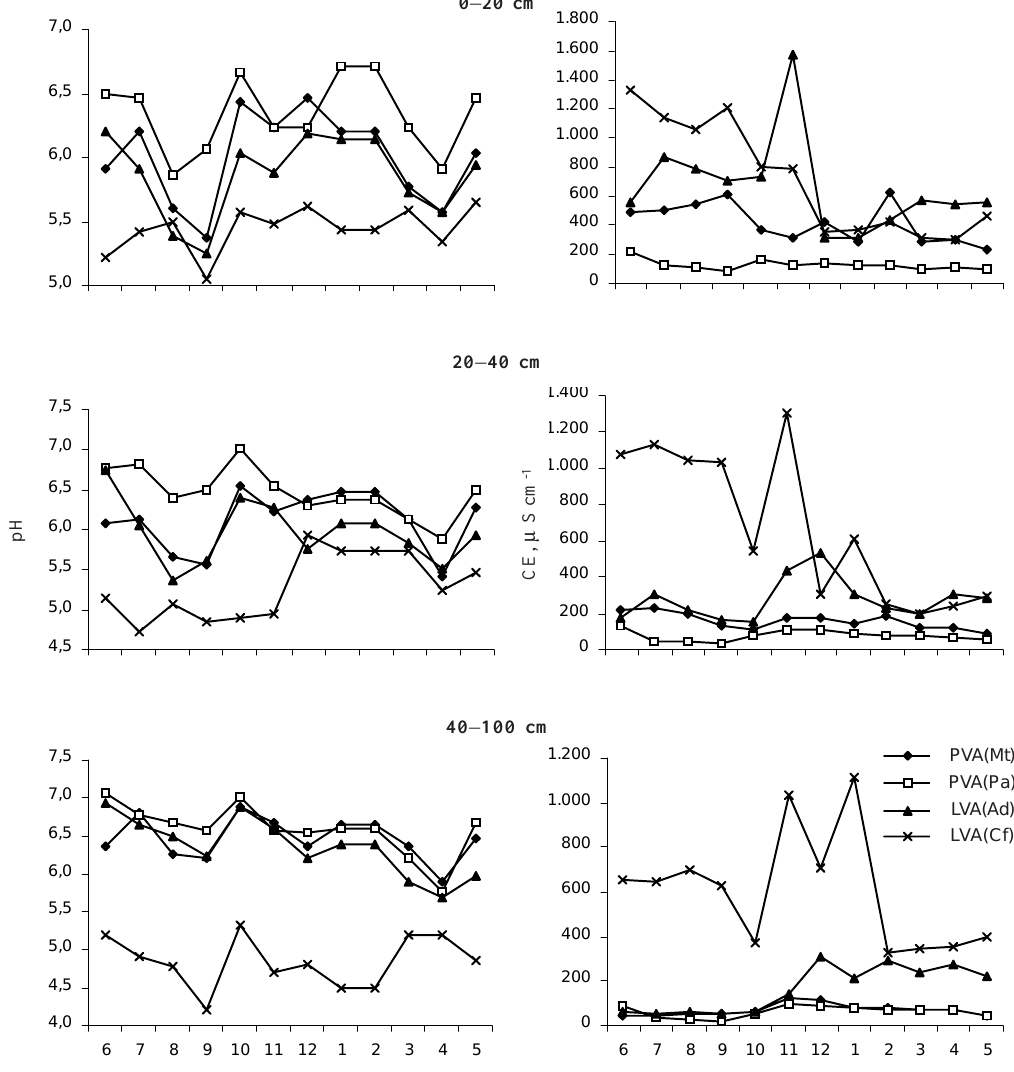
Figura 1. Variação mensal do pH e da condutividade elétrica (CE) na solução do Argissolo Câmbico sob mata (PVA(Mt)) e sob pastagem (PVA(Pa)) e do Latossolo Vermelho-Amarelo sem cobertura vegetal (LVA(Ad)) e sob cafeeiro (LVA(Cf)), no período de junho de 1996 a maio de 1997, em três profundidades. Média de três